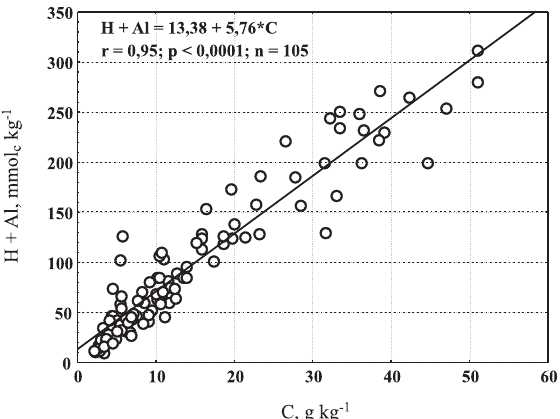
Figura 4. Relação entre o C e a acidez potencial (H + Al) para os horizontes espódicos de todos os perfis estudados. A boa correlação entre as variáveis evidencia que o C é o principal responsável pelo desenvolvimento da acidez nos solos sob vegetação de restinga.